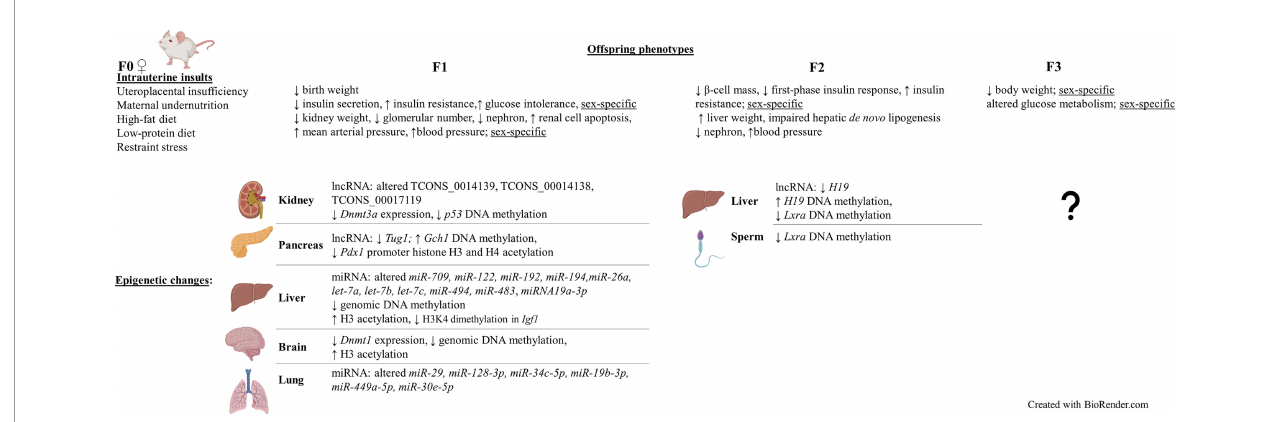
FIGURE 2 | Intrauterine growth restriction (IUGR) phenotypes are sex-speci fi c and can be transmitted to subsequent generations, including the restricted F1 and non-restricted F2 and F3 offspring (intergenerational). Similar to human studies, altered epigenetic mechanisms such as non-coding RNA modi fi cations, DNA methylation, and histone modi fi cations were also found in these offspring. Results obtained from differerent rat and mouse IUGR models (2, 10 – 15, 18, 42